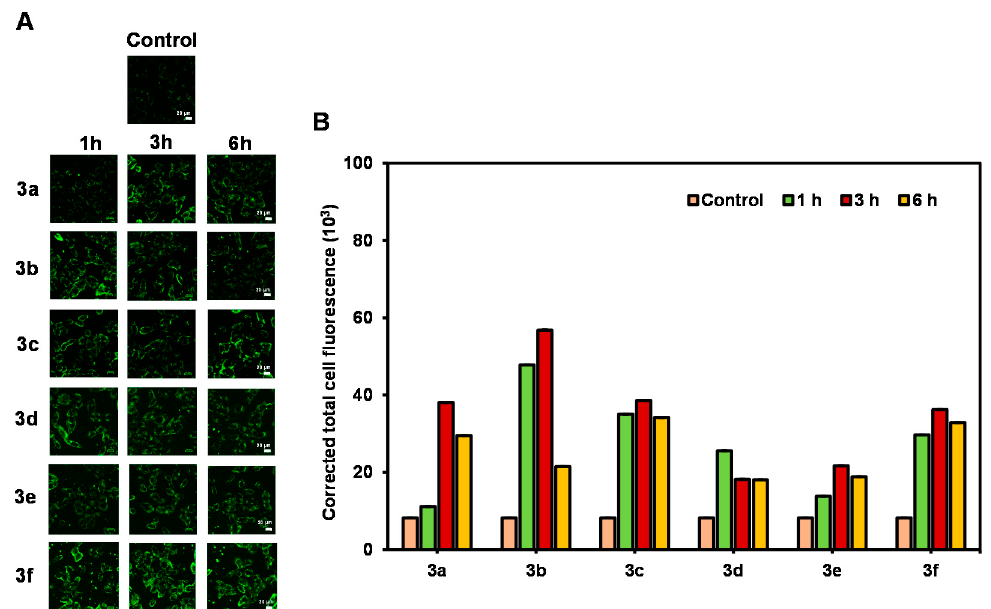
Figure 6. ( A ) CLSM images of HepG2 cells incubated with 5 µ M of chalcones 3a – f for 1–6 h. Scale bar = 20 µ m. ( B ) Corrected total cell fluorescence data quantified using ImageJ and represent the mean ± SD ( n = 30).